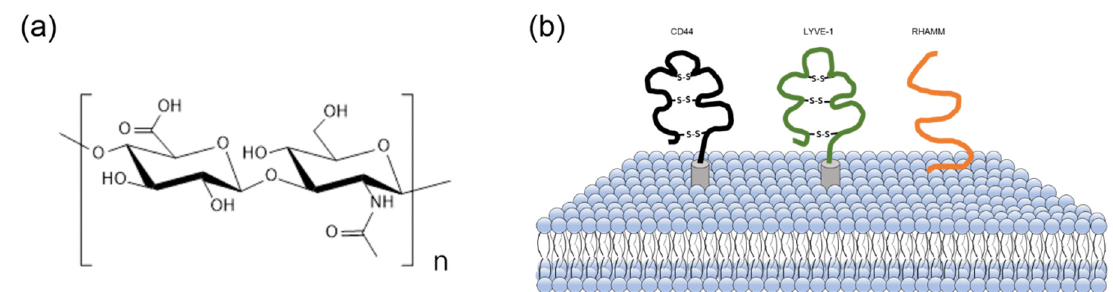
Figure 1. ( a ) The structure of hyaluronic acid, composed of alternating units of D-glucuronic acid and N-acetyl-D-glucosamine, ( b ) hyaluronic acid receptors in the cell: cluster of differentiation 44 (CD44), lymphatic vessel endocytic receptor (LYVE-1), and the receptor for hyaluronic acid-mediated motility (RHAMM) .